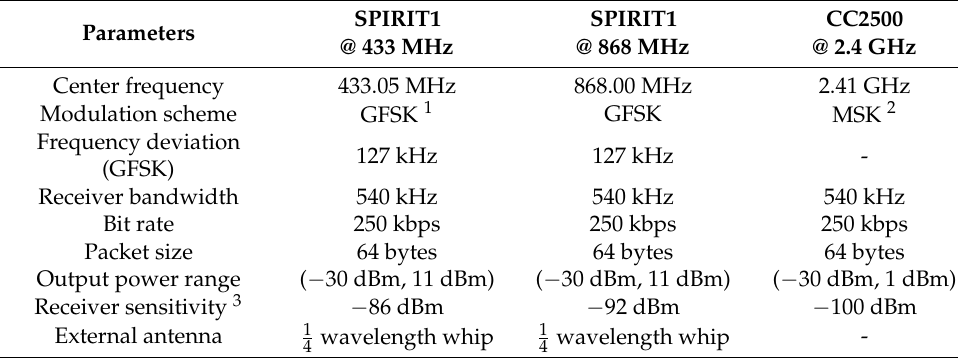
Table 1. Configuration of the wireless parameters of the test platform. SPIRIT1 SPIRIT1 CC2500 Parameters @ 433 MHz @ 868 MHz @ 2.4 GHz Center frequency 433.05 MHz 868.00 MHz 2.41 GHz Modulation scheme GFSK 1 GFSK MSK 2 Frequency deviation 127 kHz 127 kHz - (GFSK) Receiver bandwidth 540 kHz 540 kHz 540 kHz Bit rate 250 kbps 250 kbps 250 kbps Packet size 64